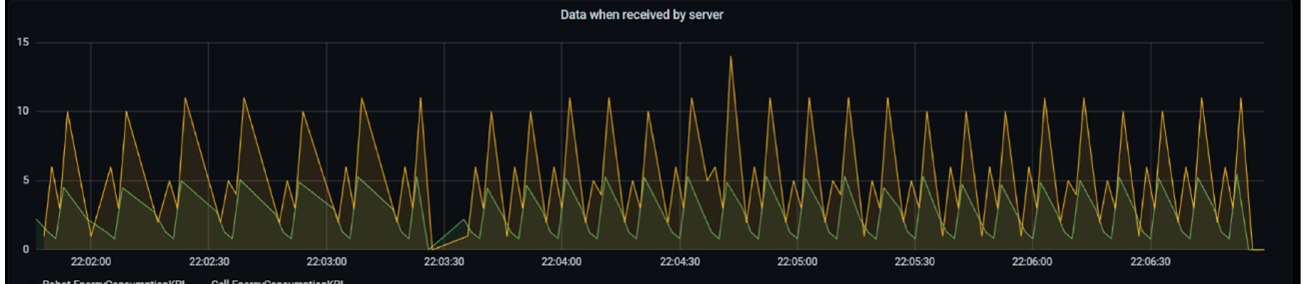
Figure 13. Energy Consumption Evolution in one Robotic Cell .